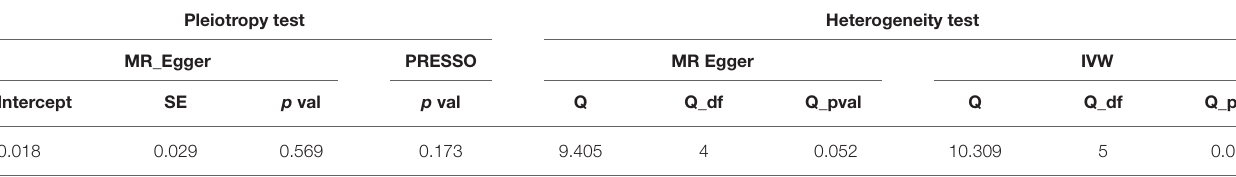
TABLE 4 | Pleiotropy test of plasma omega-3 genetic IVs in GWAS for low back pain.